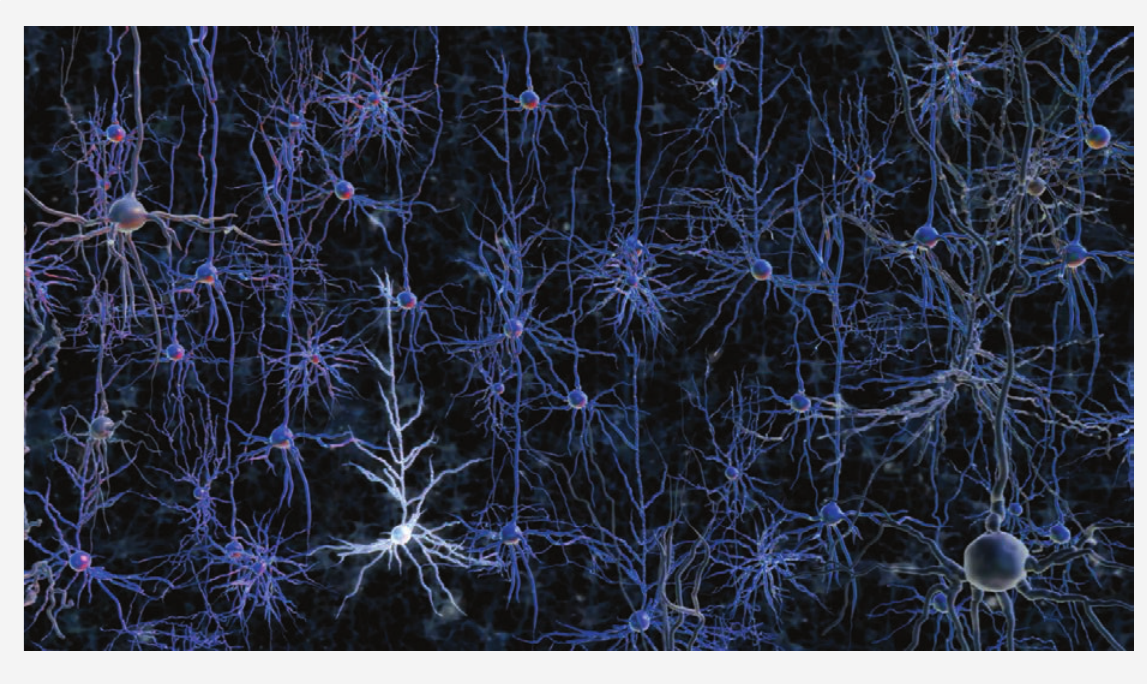
Figure 1. Cartoon of brain cells (neurons), with one neuron “lighting up,” representing its electrical activity . In the real brain, there is no space between the neurons, as in this illustration; they are densely packed into intertwined neural networks.